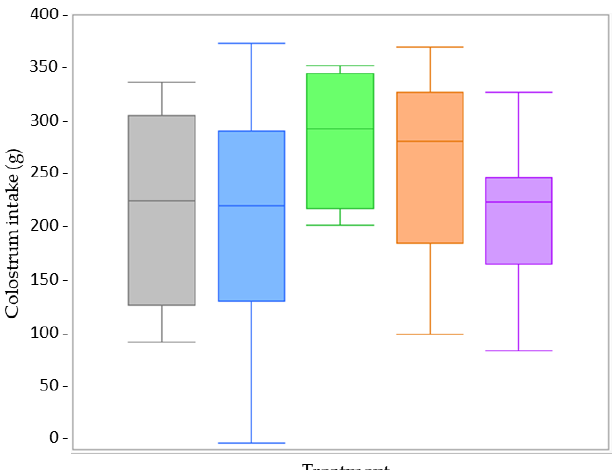
Figure 6. Boxplots of the low birth weight piglets’ colostrum intake per treatment (dense milk replacer [DMR] one dose [grey box], DMR three doses [blue box], no treatment [green box], sham one dose [orange box], sham three doses [purple box]) at Farm B (high perinatal management; n = 33). Colostrum intake did not differ significantly between the different treatment groups ( p = 0.277).